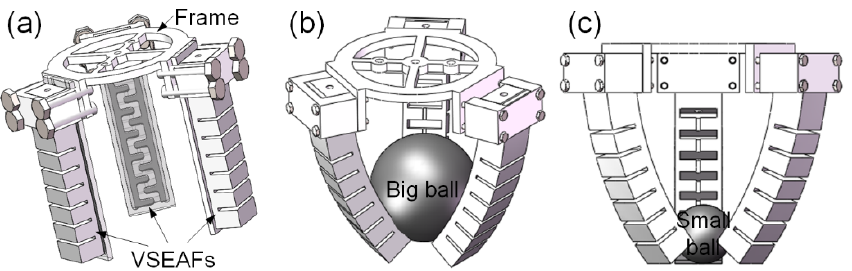
Figure 10. Schematic diagram demonstrating grasping capabilities: ( a ) the designed three-fingered VSEAFs gripper, ( b ) envelope grasping and ( c ) utilizing a fingertip to seize.